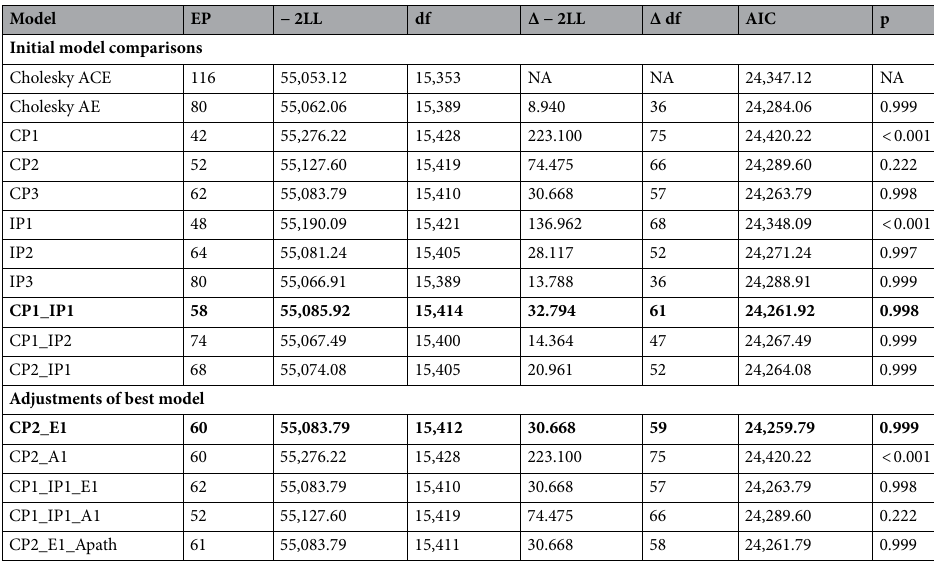
Table 4. Model comparisons for multivariate twin models. EP number of estimated parameters, LL LogLikelihood, df degrees of freedom, Δ difference as compared to base model, AIC Akaike’s Information Criterion, p p-values from test of difference from base model. Best fitting model indicated in bold. CP and IP stand for common and independent pathway respectively. The numbers after CP and IP indicate the number of factors of that kind in the model. E1 signifies the addition of an extra E factor to a model. Apath represents a path from the A-component of a CP-factor onto the other CP-factor. All models in the table except the Cholesky ACE are pure AE models, with no C